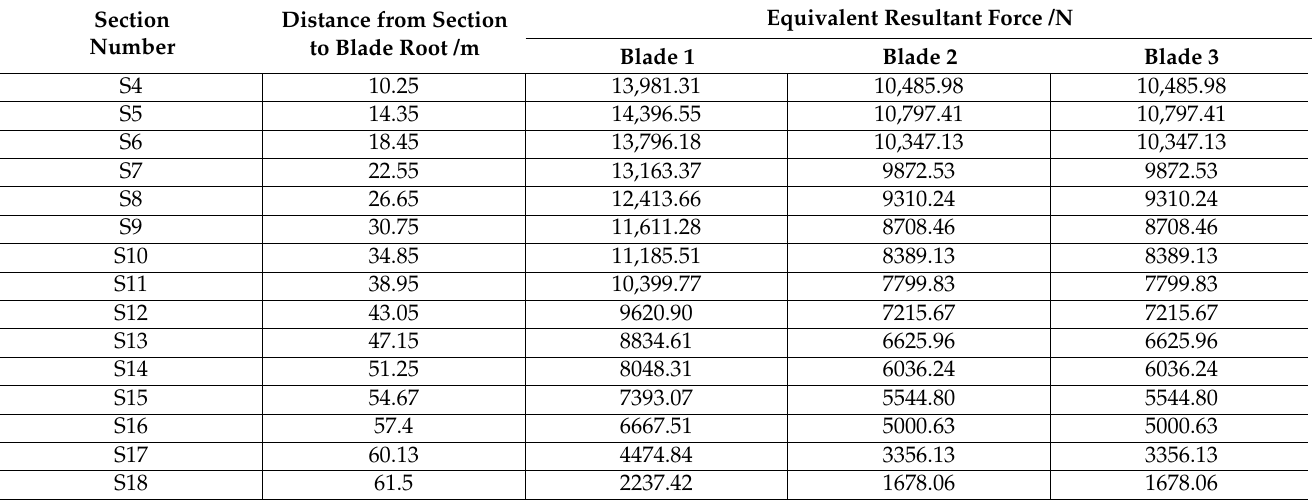
Table 3. Aerodynamic load under extreme